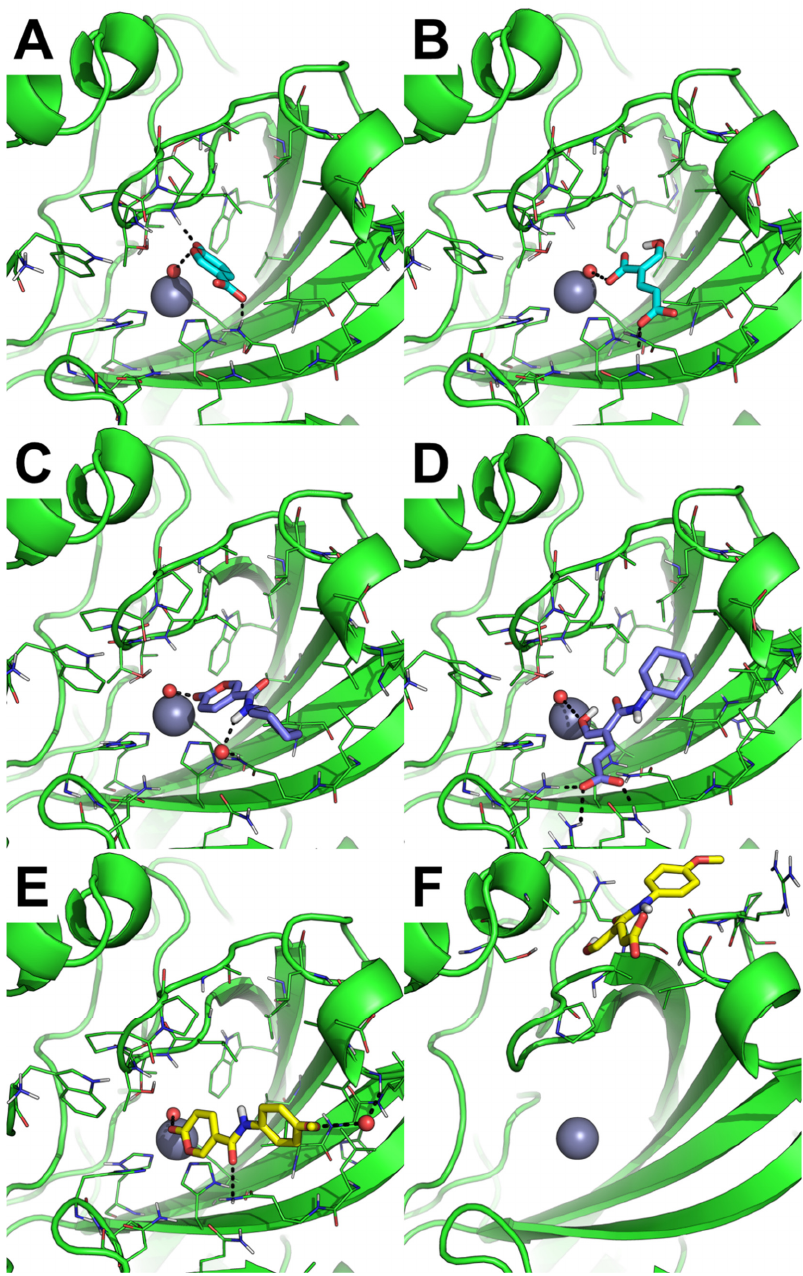
Figure 9. Predicted binding mode of compounds 1 ( A , B ), 14 ( C , D ), and 6 ( E , F ) in their open and closed forms as investigated through 500 ns of MD simulations. The representative frame extracted from MD trajectory by cluster analysis is shown in each panel. The protein is shown as green cartoon and lines, residues at a distance higher than 5 Å from the ligand are omitted for the sake of clarity. Compound 1 is shown as cyan sticks, compound 14 as blue sticks, compound 6 as yellow sticks. The catalytic Zn(II) ion is shown as a grey sphere, water molecules bridging the protein and the ligand are shown as small red spheres, all other water molecules and counter-ions were omitted. Polar interactions are highlighted by black dashed